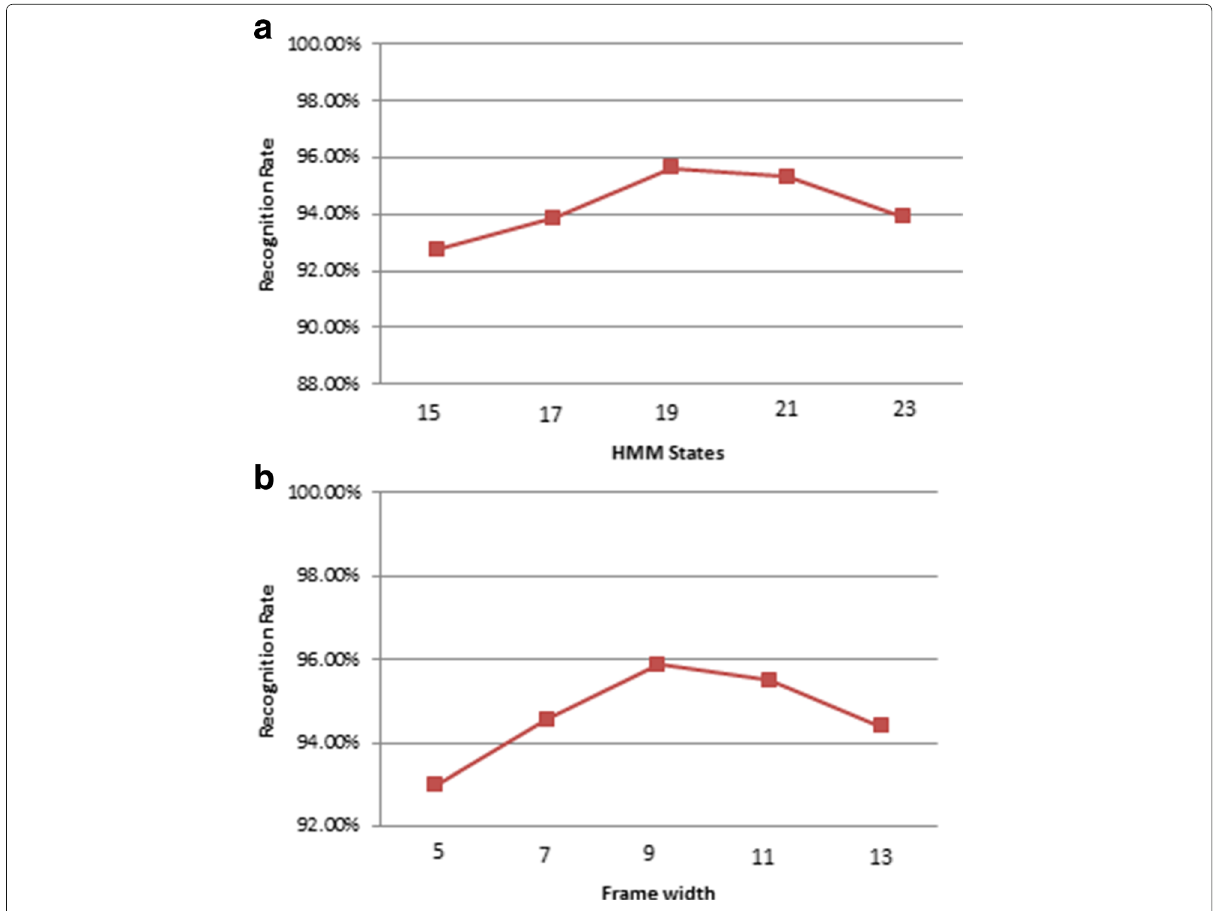
Fig.17 Classification rates (500 ligatures) as a function of a HMM states (window width = 9) b window width for feature extraction (HMM states =